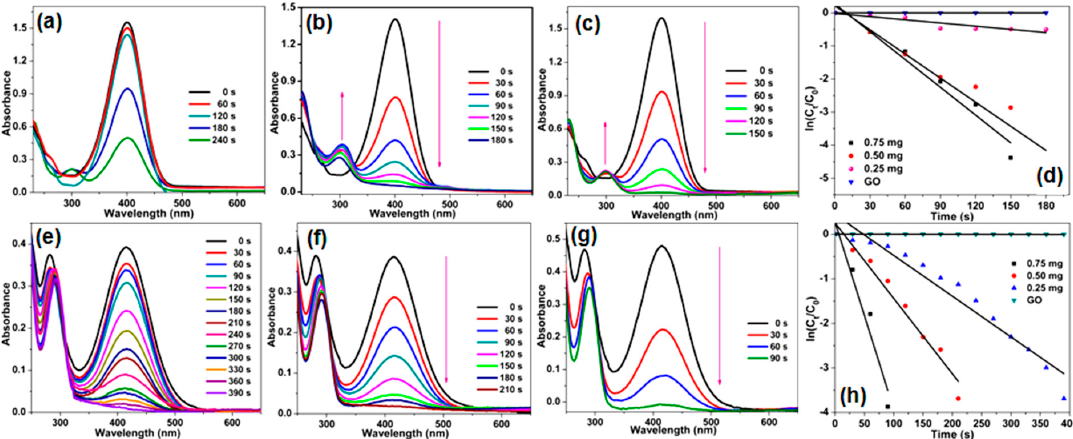
Figure 9. UV–vis spectra of the reduction of ( a – c ) 4-NP and ( e – g ) 2-NP in aqueous solution recorded every 30 s using different amount of Ni/GO-2 (0.25, 0.50 and 0.75 mg). Plots of ln[C t /C 0 ] versus reaction time for the reduction of ( d ) 4-NP and ( h ) 2-NP with NaBH 4 over Ni/GO-2.